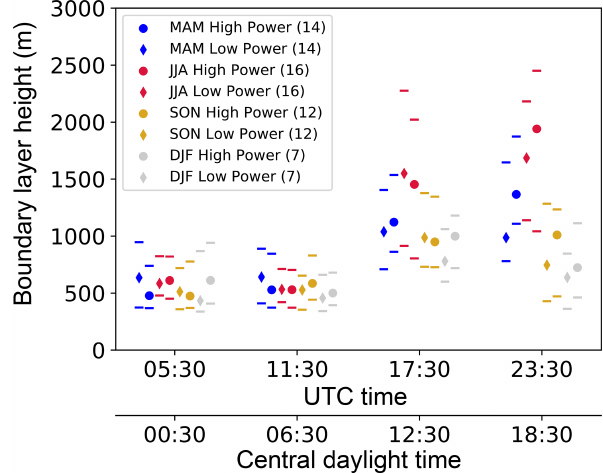
Figure 9. Diurnal cycle of boundary layer heights at the SGP site for each season, as estimated from radiosonde data. The circles rep- resent the median boundary layer height for the top 25% of the weekly data in terms of power associated with the diurnal cycle in N 7 − 30nm (High Power). Similarly, the diamonds represent the median boundary layer height for the bottom 25% of the weekly data (Low Power). The horizontal lines above and below the circles and diamonds represent the 25th and 75th percentiles (interquartile ranges) for these data. The numbers in parentheses represent the number of weekly time periods used in this analysis. The abscissa offset for each radiosonde launch time is for viewing purposes and does not reflect any shift in timing for each of the four radiosonde launch times for the different